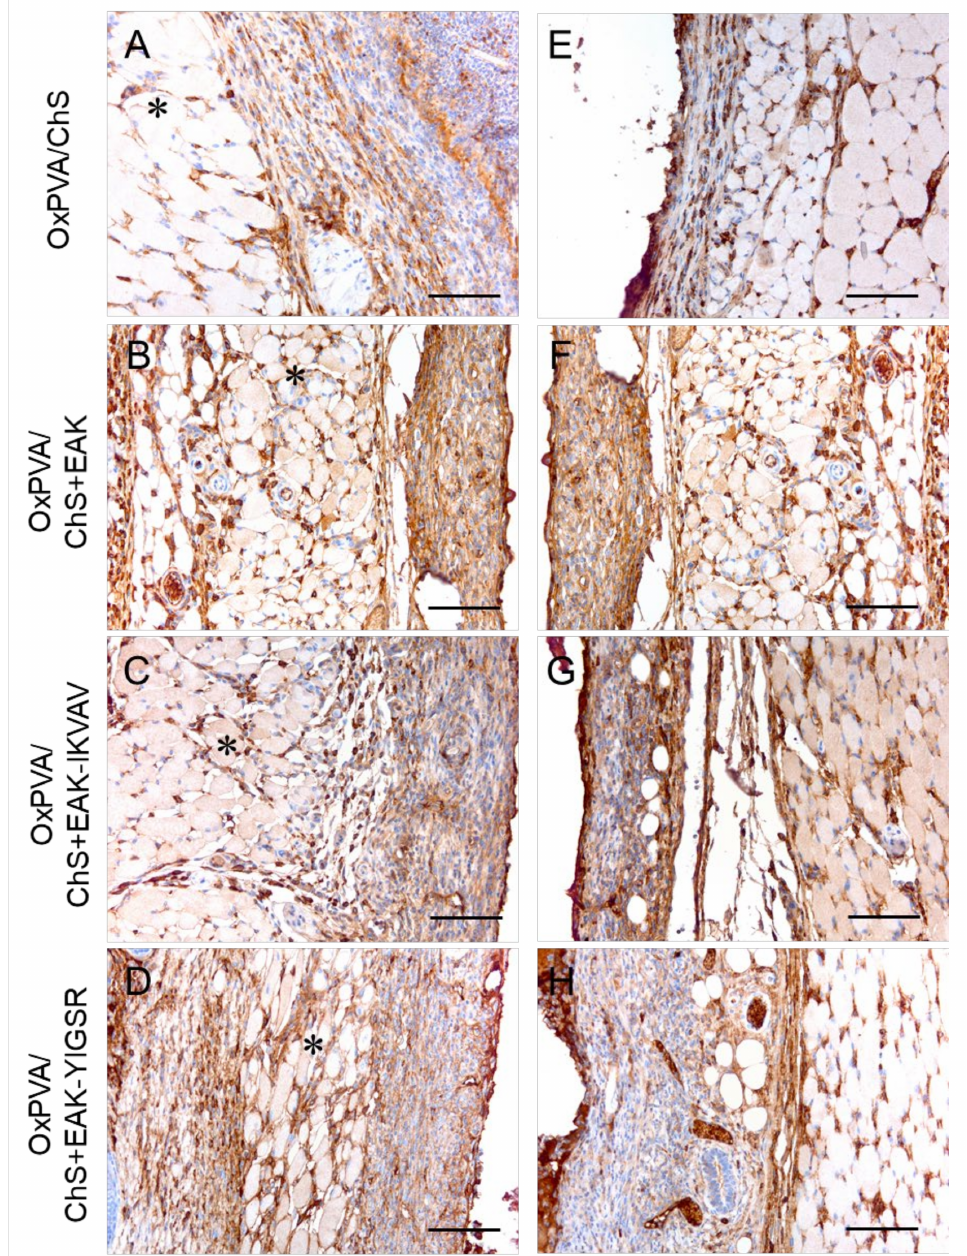
Figure 8. Immunolocalization of the monocyte-macrophage (F4/80+ cells) infiltration at the superfi- cial ( A – D ) and deep ( E – H ) aspects of the grafts after the subcutaneous implantation of OxPVA/ChS- based scaffolds for 14 days. Scale bar: 100 µ m. (*: the panniculus carnosus within the host subcuta- neous